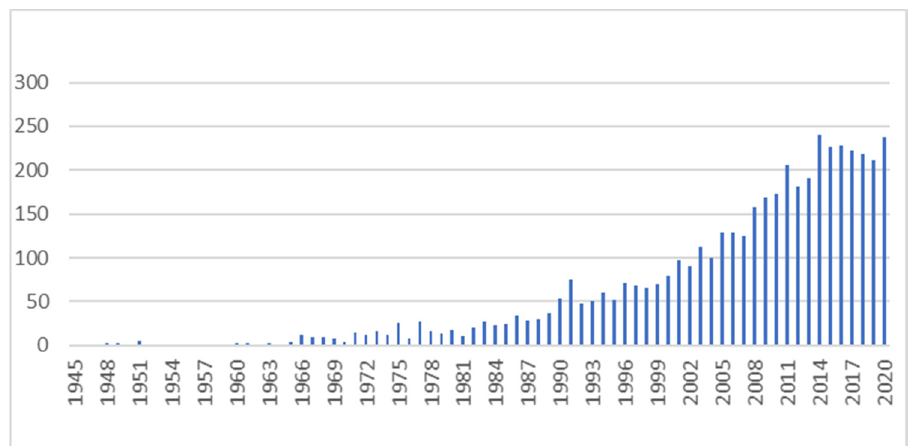
Figure 1. Number of articles related to dental erosion published in PubMed per year since 1945 to the present time.